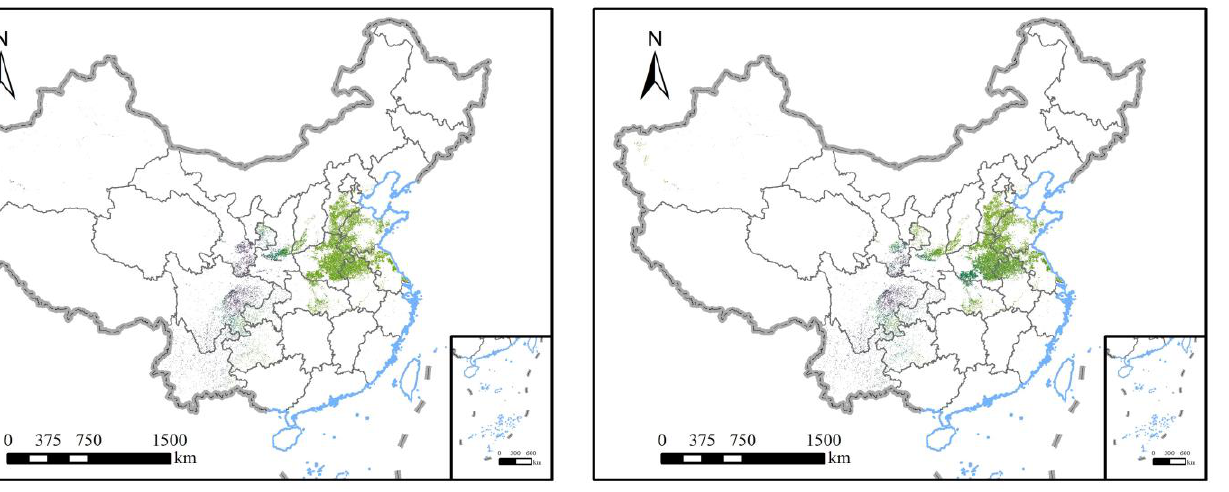
Table 5. TSS and AUC of the single models. The AUC value is between 0.5 and 1, while the TSS value is between − 1 and 1.